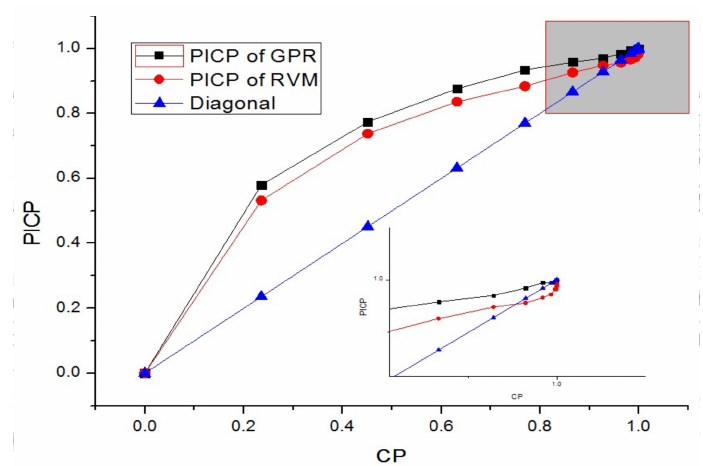
Figure 10. ROC-PI curves of RVM and GPR for the solar array current series.